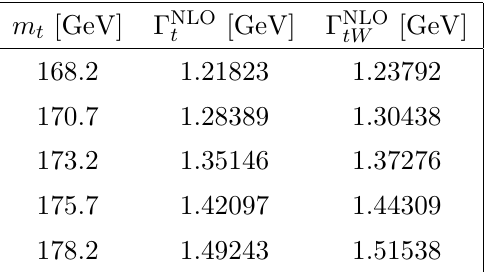
NLO refers to the top quark width with W t . (cid:0) t to the top quark width with the on-shell W gauge tW